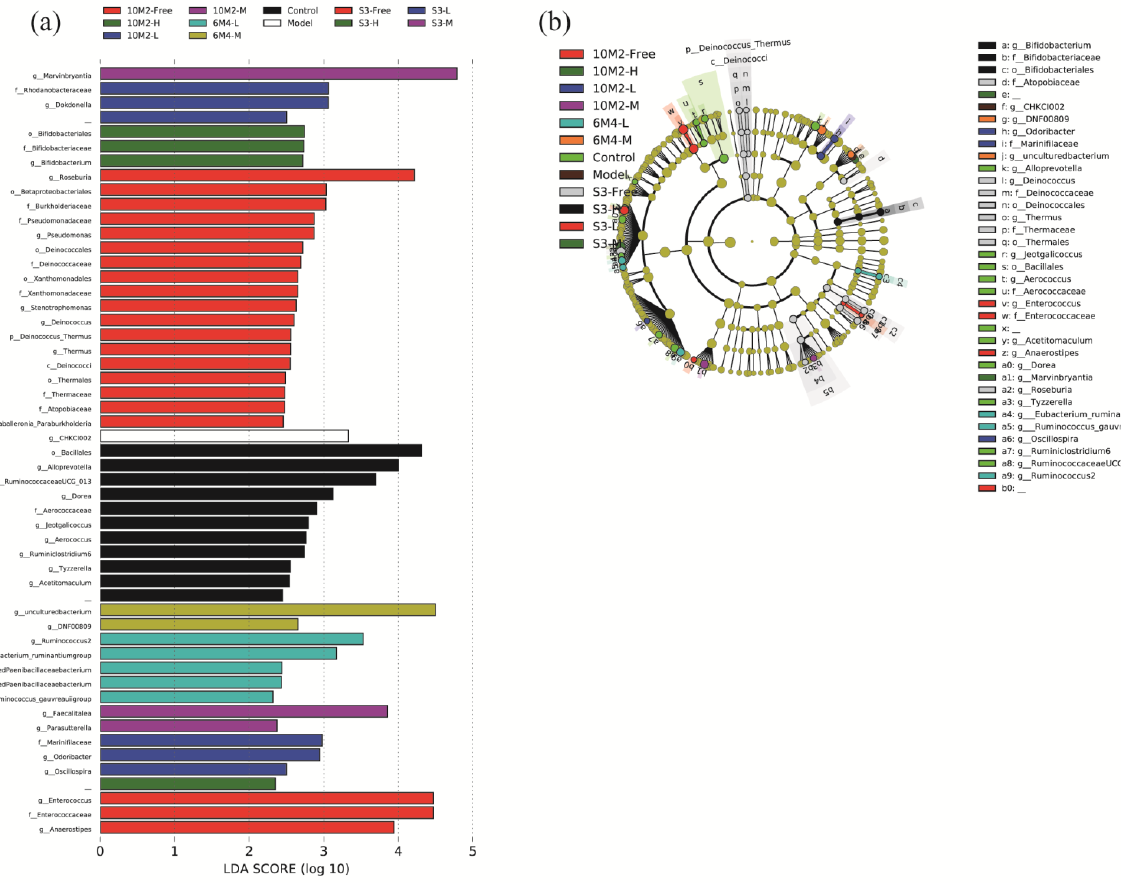
Figure 6. The linear discriminant analysis effect size (LEfSe) analysis of fecal flora. ( a ) LDA score of characteristic bacteria (LDA > 2); ( b ) phylogenetic tree illustrating the taxonomic hierarchy of bacteria, which varies in terms of relative abundance between the various groupings. The relative abundance of each taxon is proportional to the size of the circle.